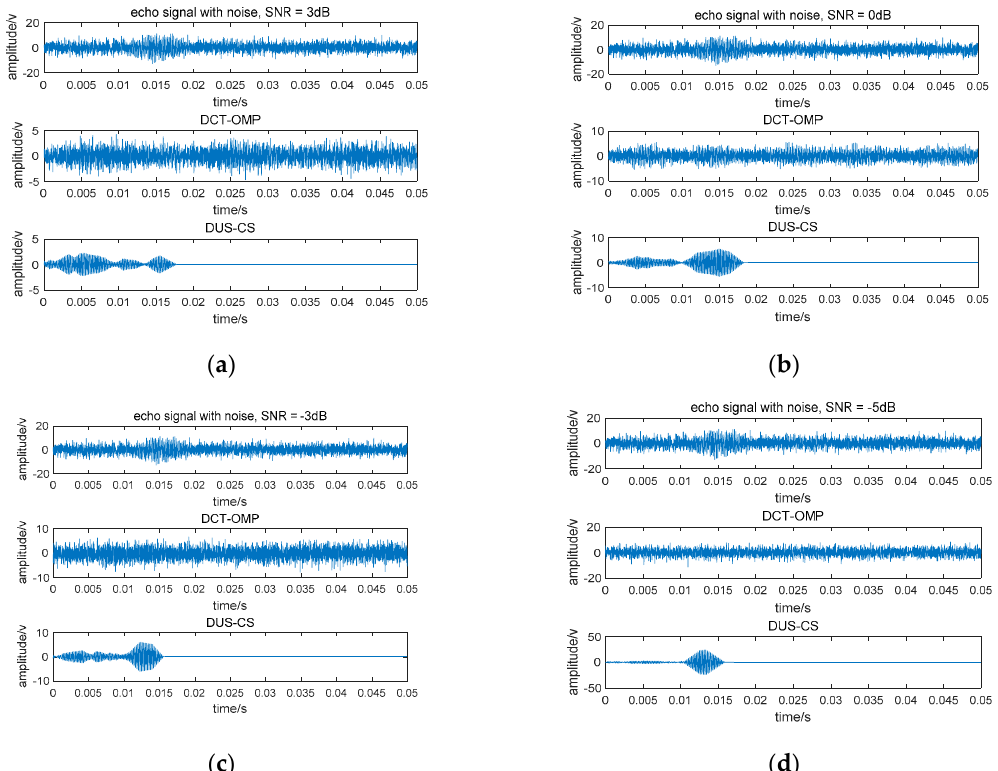
Figure 5. Reconstruction signals at a compression ratio of 20%. ( a ) SNR = 3dB; ( b ) SNR = 0dB; ( c ) SNR = − 3dB; ( d ) SNR = − 5dB.